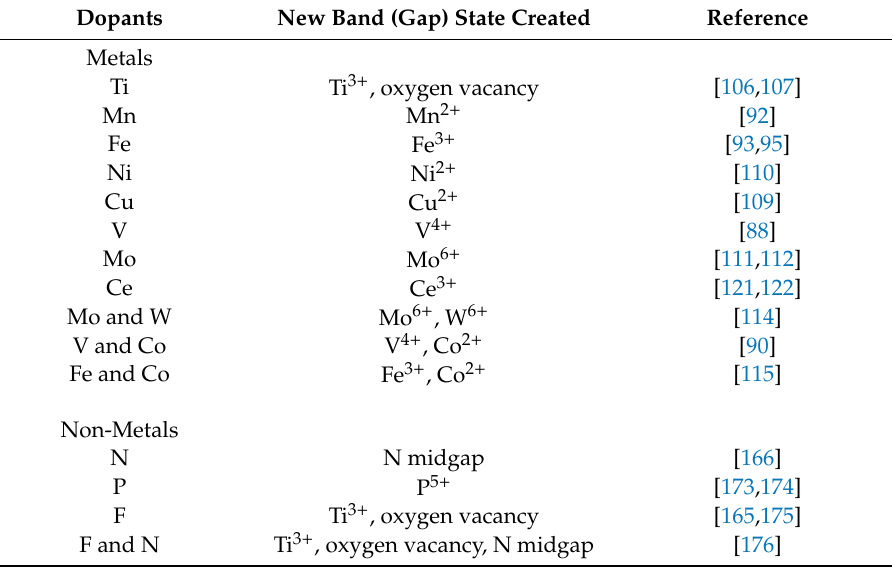
Table 1. Visible-light active TiO 2 NPs doped with metals and